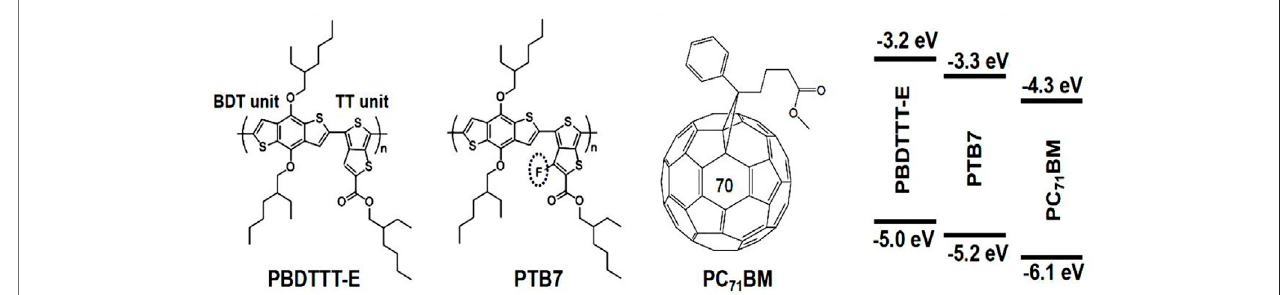
FIGURE 1 | Chemical structures of PBDTTT-E, PTB7, and PC 71 BM and their energy